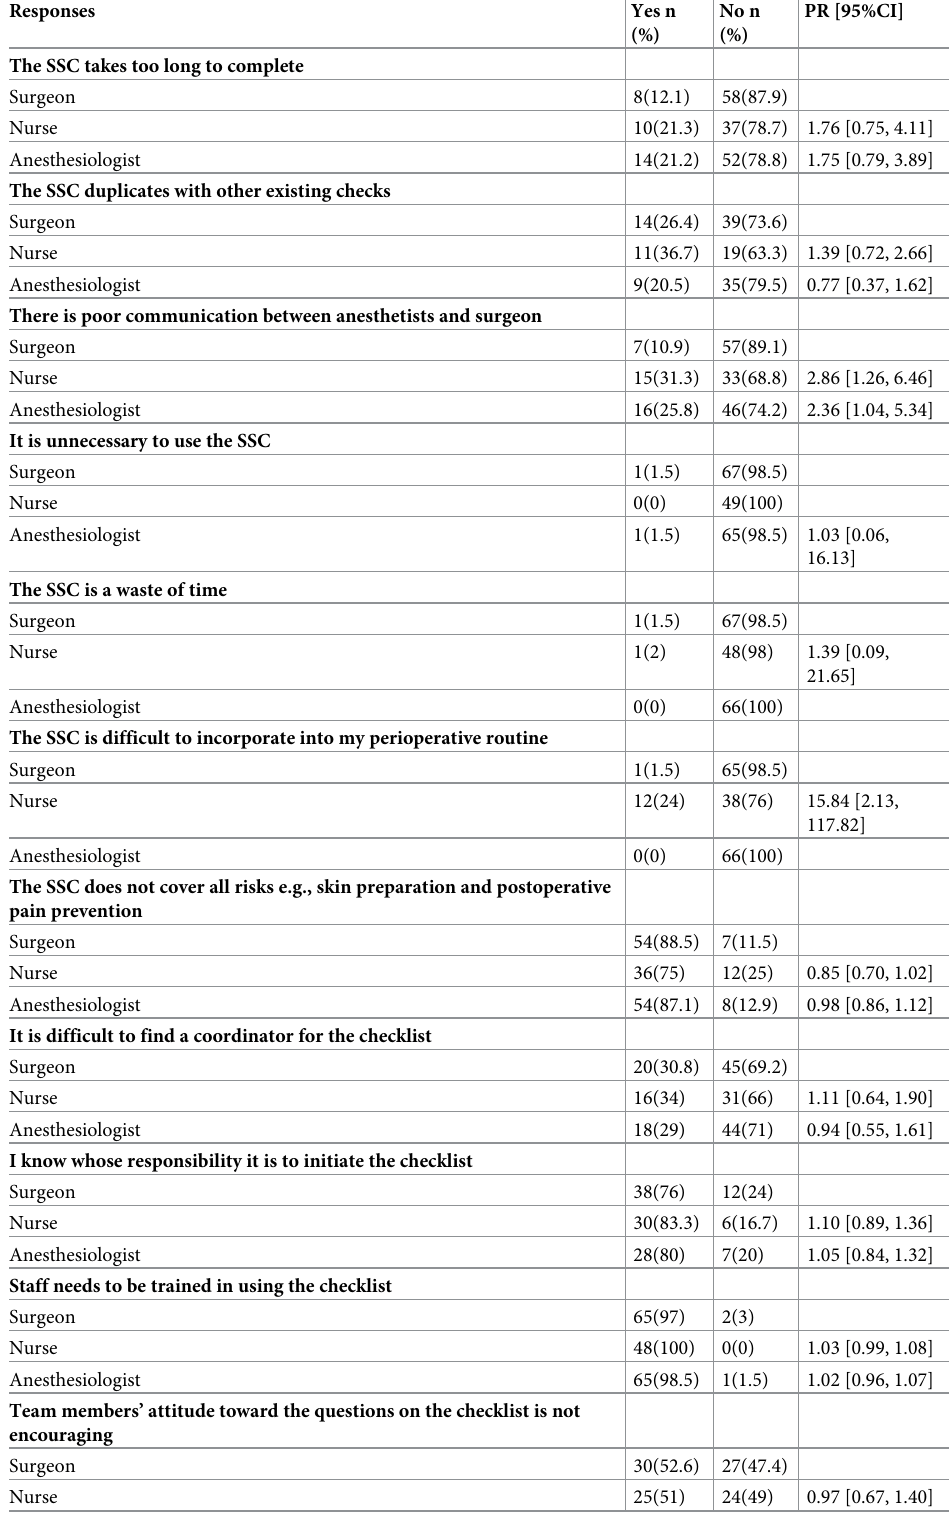
Table 3. Cross-tabulation of identified barriers and perceptions against the type of surgical